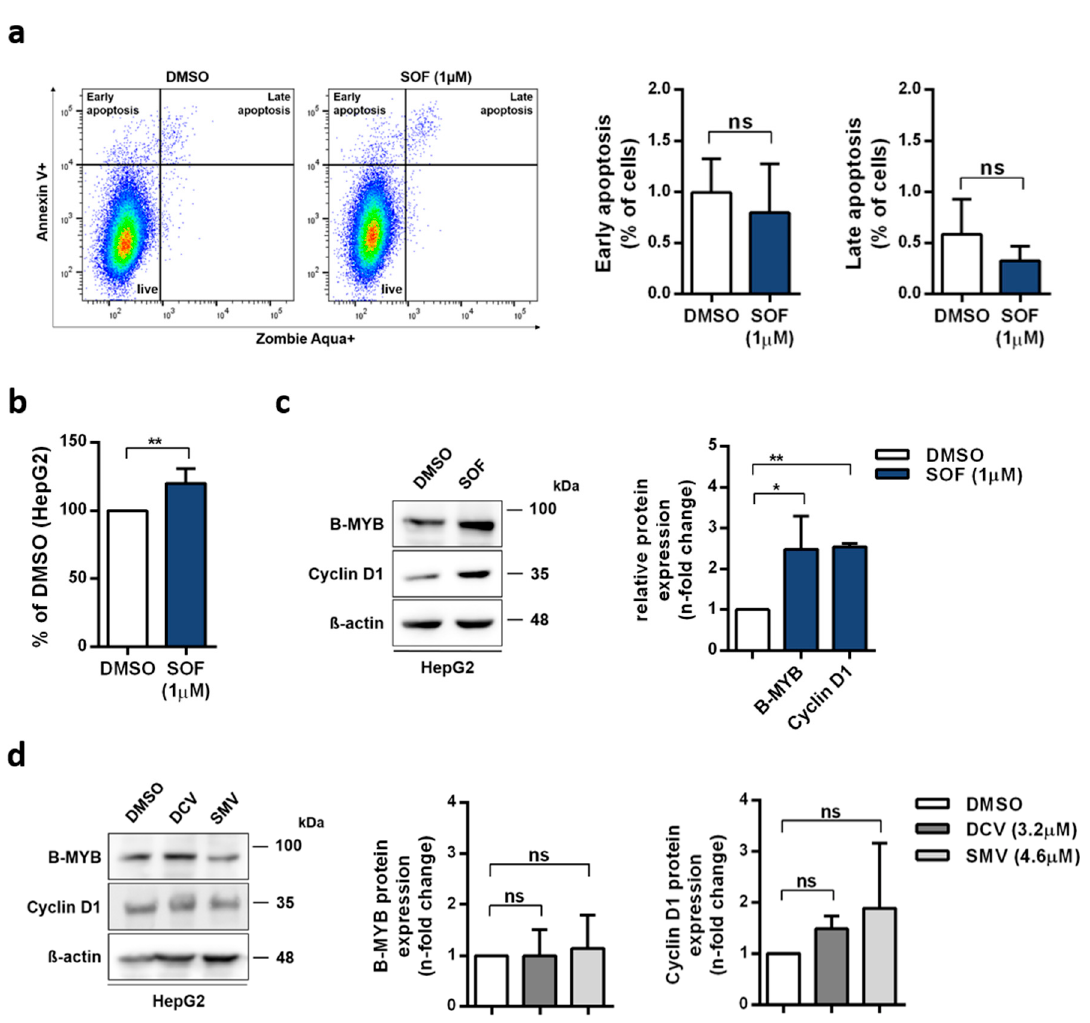
Figure 2. Impact of SOF treatment on cell cycle progression ( a ) Proportion of apoptotic cells was determined with Annexin V and live / dead cells staining in HepG2 cells incubated with SOF at day five. ( b ) Proliferation rates of SOF-treated cells were evaluated by trypan blue exclusion and displayed in relation to the vehicle control DMSO. ( c , d ) B-MYB and Cyclin D1 protein expression after SOF ( c ) and DCV or SMV ( d ) treatment were analyzed by immunoblot. One representative immunoblot is shown. Bar graph displays relative protein expression as fold change in relation to DMSO. All shown data represent mean + s.d. from three (a, b, c B-MYB, d) and two (d CyclinD1) independent experiments. Statistical significance was determined through one-way ANOVA ( c , d ) and unpaired t -test ( a , b ). ns: not significant; * p ≤ 0.05; ** p ≤